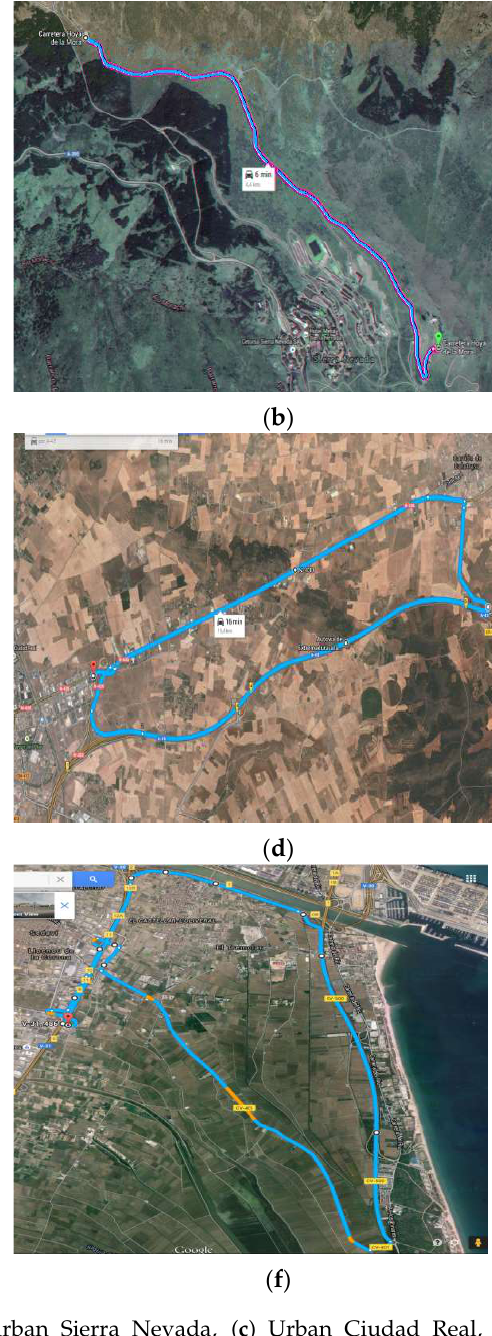
Figure 3. ( a ) Urban Sierra Nevada, ( b ) Extra-urban Sierra Nevada, ( c ) Urban Ciudad Real, ( d ) Extra- urban Ciudad Real, ( e ) Urban Valencia, ( f ) Extra-urban